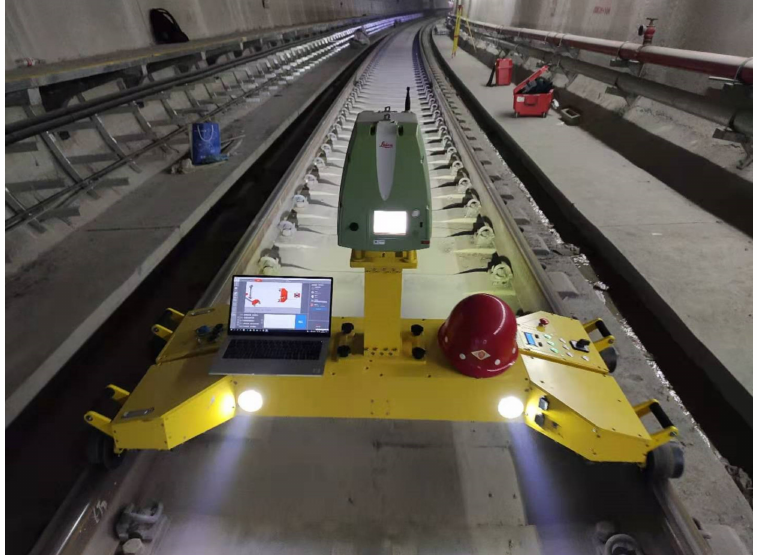
Figure 10. Mobile Tunnel Measurement System